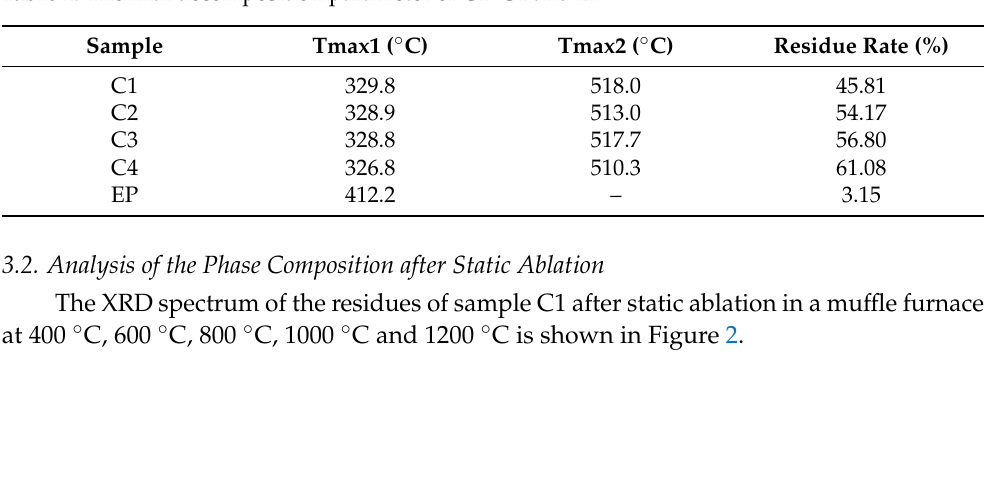
Table 2. Thermal decomposition parameter of C1–C4 and